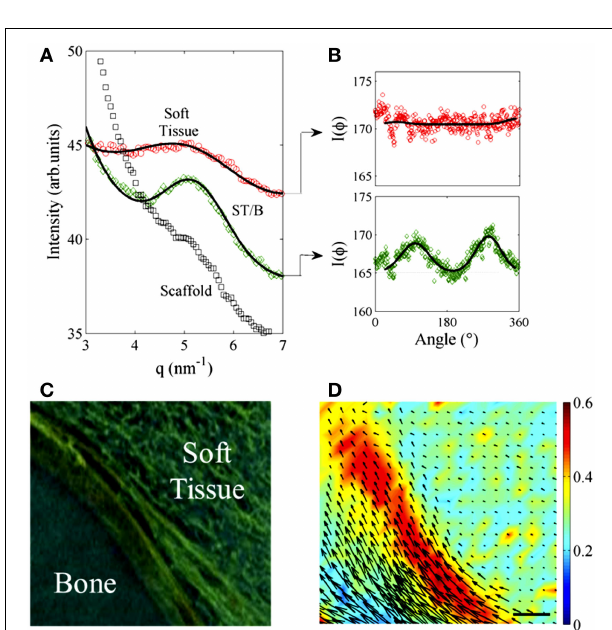
FIGURE 5 | (A) Typical diffraction radial profile, I(q), measured for ST (red circles), ST/B interface (green circles), and in the scaffold (black squares). The continuous lines represent the best fitting curves using a Gaussian line shape added to a power law behavior as background. (B) Orientation degree of the collagen molecules, given by the area under the peaks of the azimuthal profiles I( Φ ), measured in ST (red circles) and at the ST/B interface (green circles). The continuous lines are the Gaussian curve fits above a constant background. (C) XRPC μ T detail of the ST/B interface. (D) Spatial distribution of collagen molecular amount and alignment given by the color intensity and by the arrows vectors, respectively. Size-bar = 15 μ